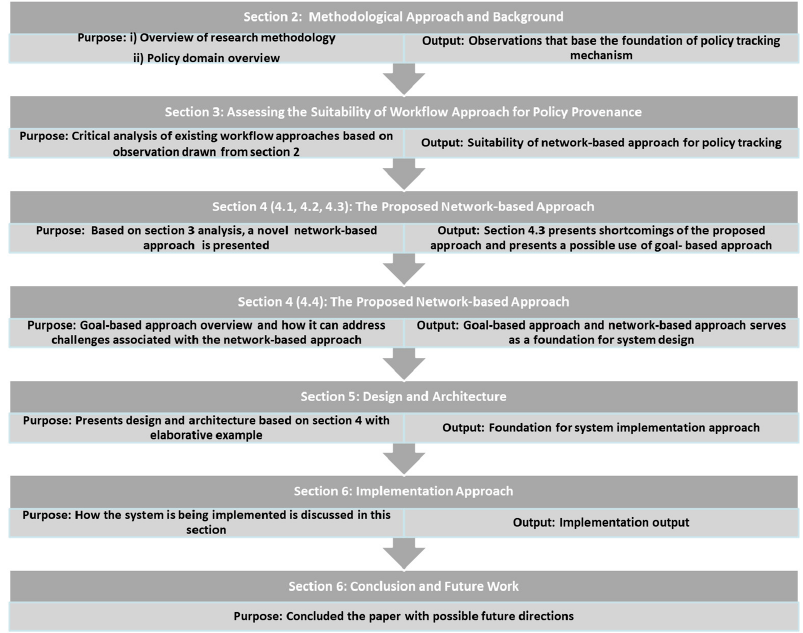
Figure 1. Conceptual Diagram of Paper Structure.